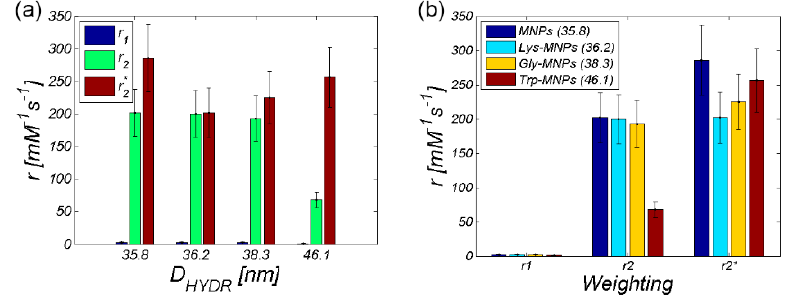
Figure 15. Comparison of the relaxivities of AA–MNP complexes depending on ( a ) hydrodynamic diameter, ( b ) weighting.